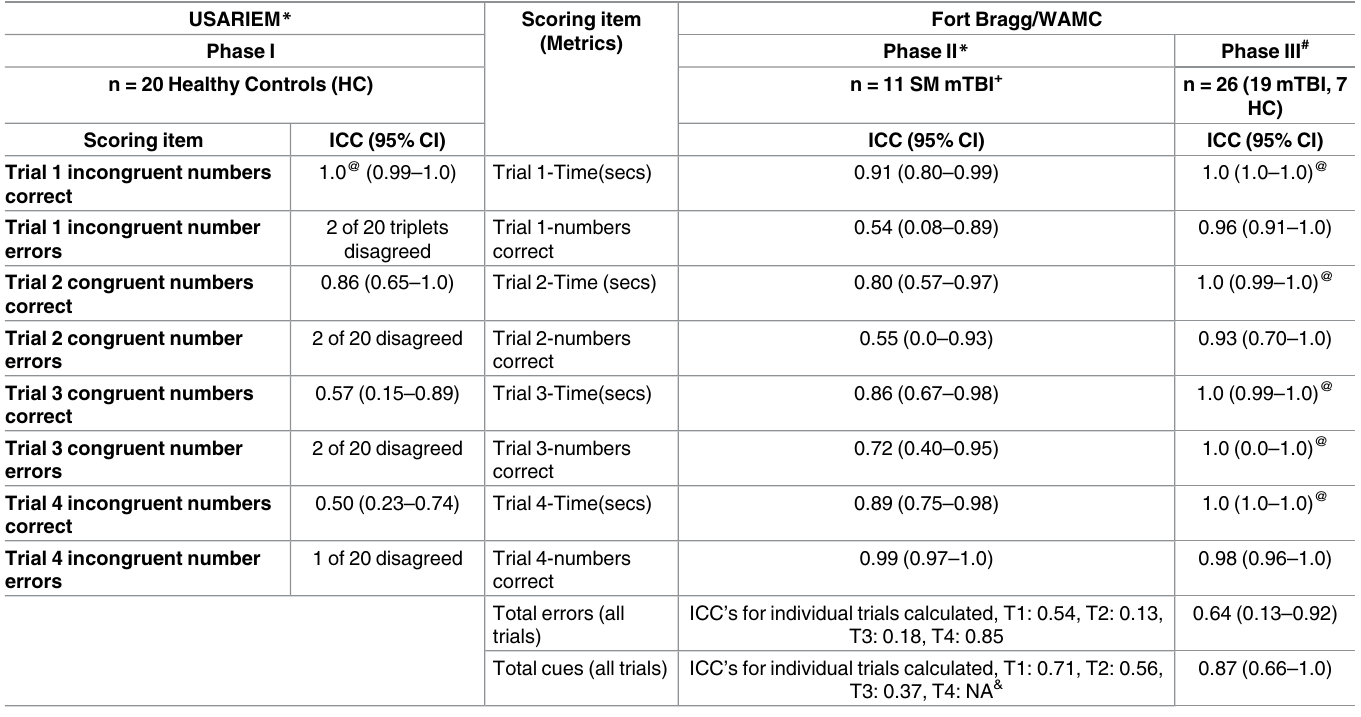
Table 8. Run-Roll-Aim (RRA)